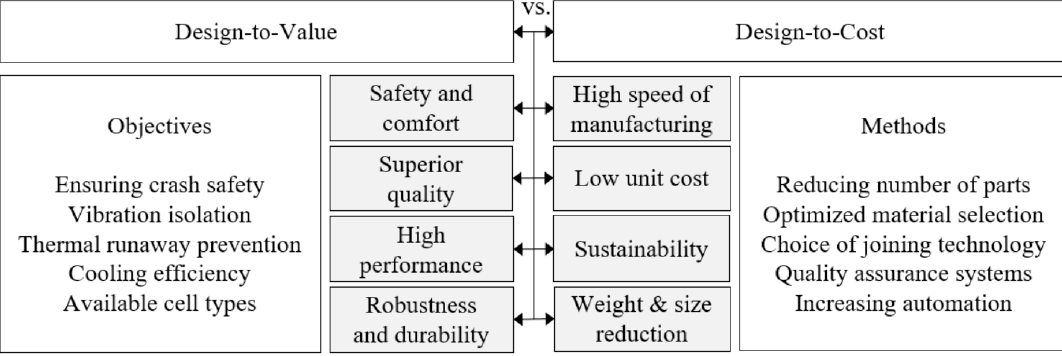
Figure 2. Design considerations in electric vehicle (EV) battery pack manufacturing.